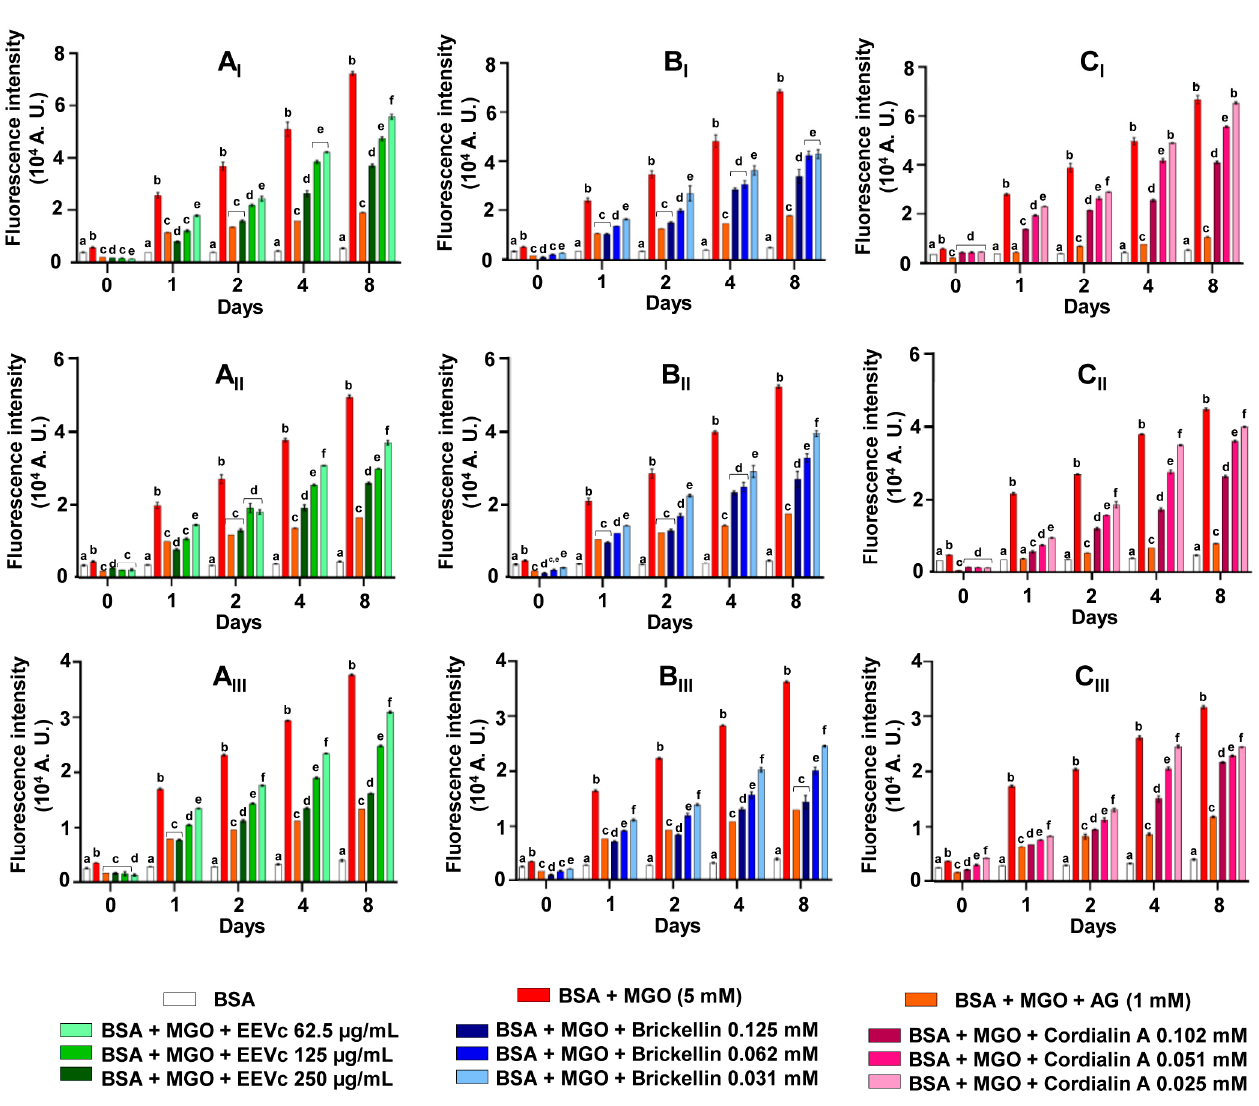
Figure 4. Effects of different concentrations of EEVc ( A ), brickellin ( B ) and cordialin A ( C ) on the formation of dithyrosine (I), N ′ -formylquinurenine (II) and quinurenine (III) in in vitro protein glycation model system with BSA + MGO. BSA: bovine serum albumin; MGO: methylglyoxal; AG: aminoguanidine; EEVc: ethanolic extract of Varronia curassavica . For all variables with the same letter, the difference between the means is not